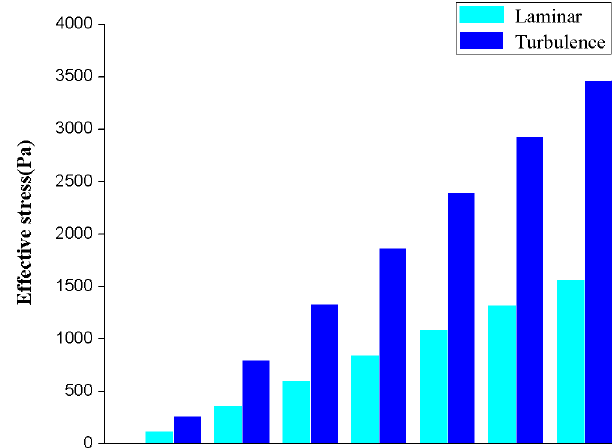
Figure 15. Cross-cutting e ff ective stress nephogram ( a ) Rock sample models of laminar flow; ( b ) Rock sample models of Turbulence.